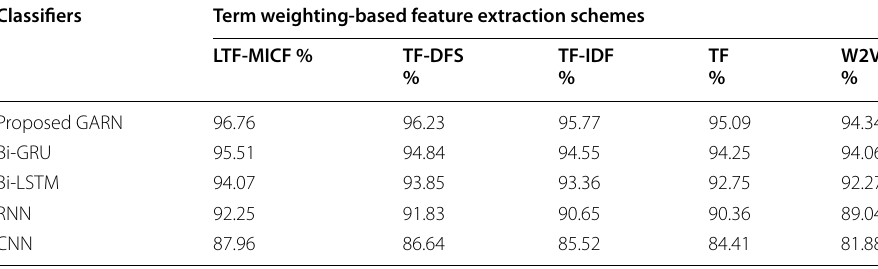
Table 7 Recall of the proposed and existing classifiers with term weights